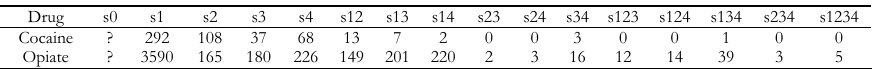
Capture profiles of the drug users in Liguria Region